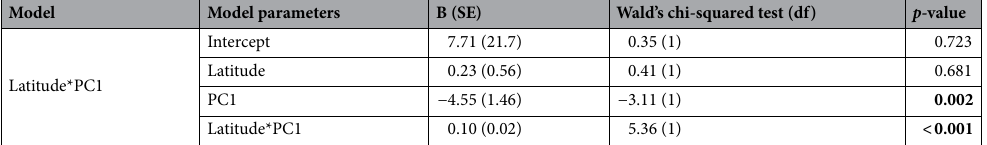
Table 1. Linear model results of the best model on the effects of latitude and/or climatic factors (PC1) on chill coma recovery time. Model selection was based on Bayesian Information Criterion (BIC) results (shown in Table S8). Significant P -values are shown in bold. df degrees of